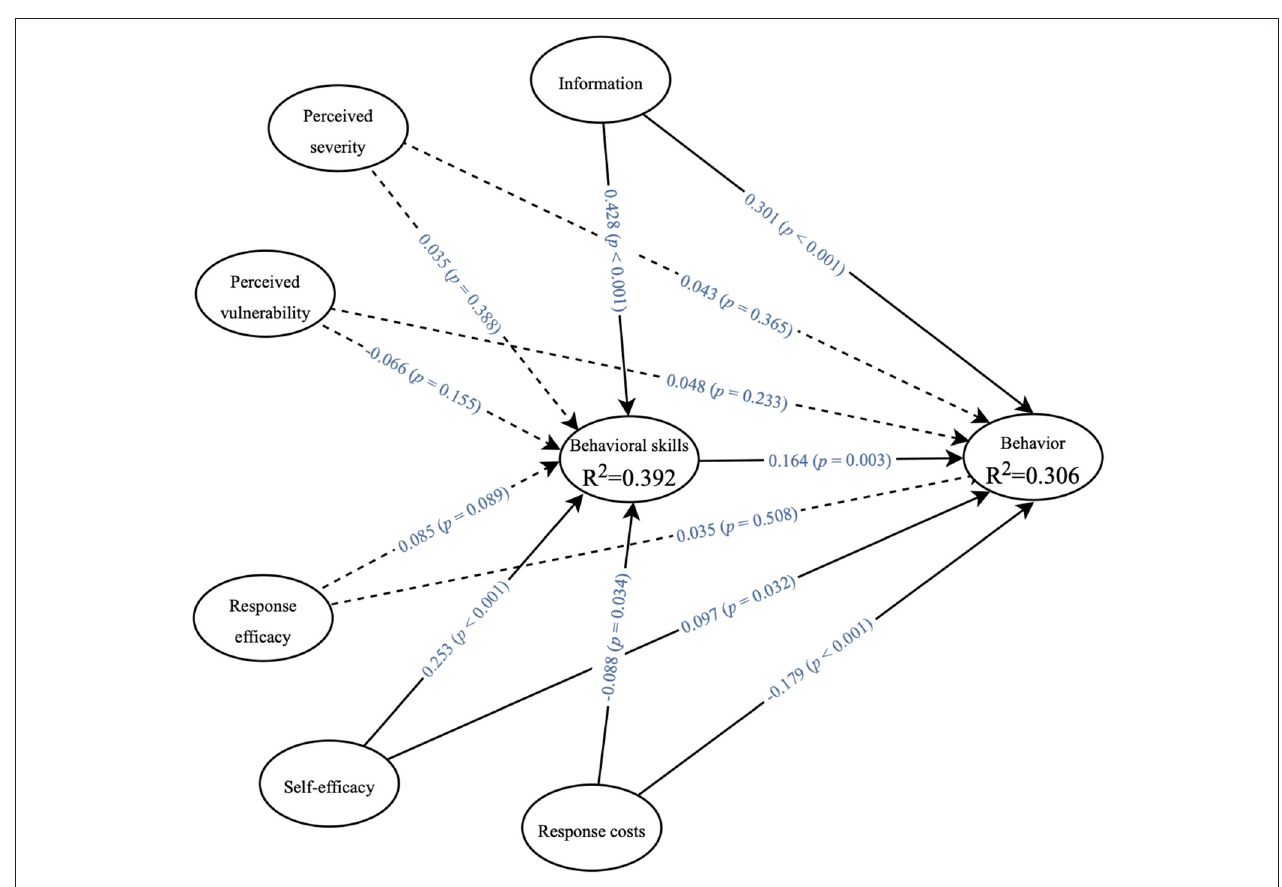
FIGURE 2 | Significance testing results of the structural model path coefficient. Behavior, behavior during pregnancy; Dotted paths indicated non-significant